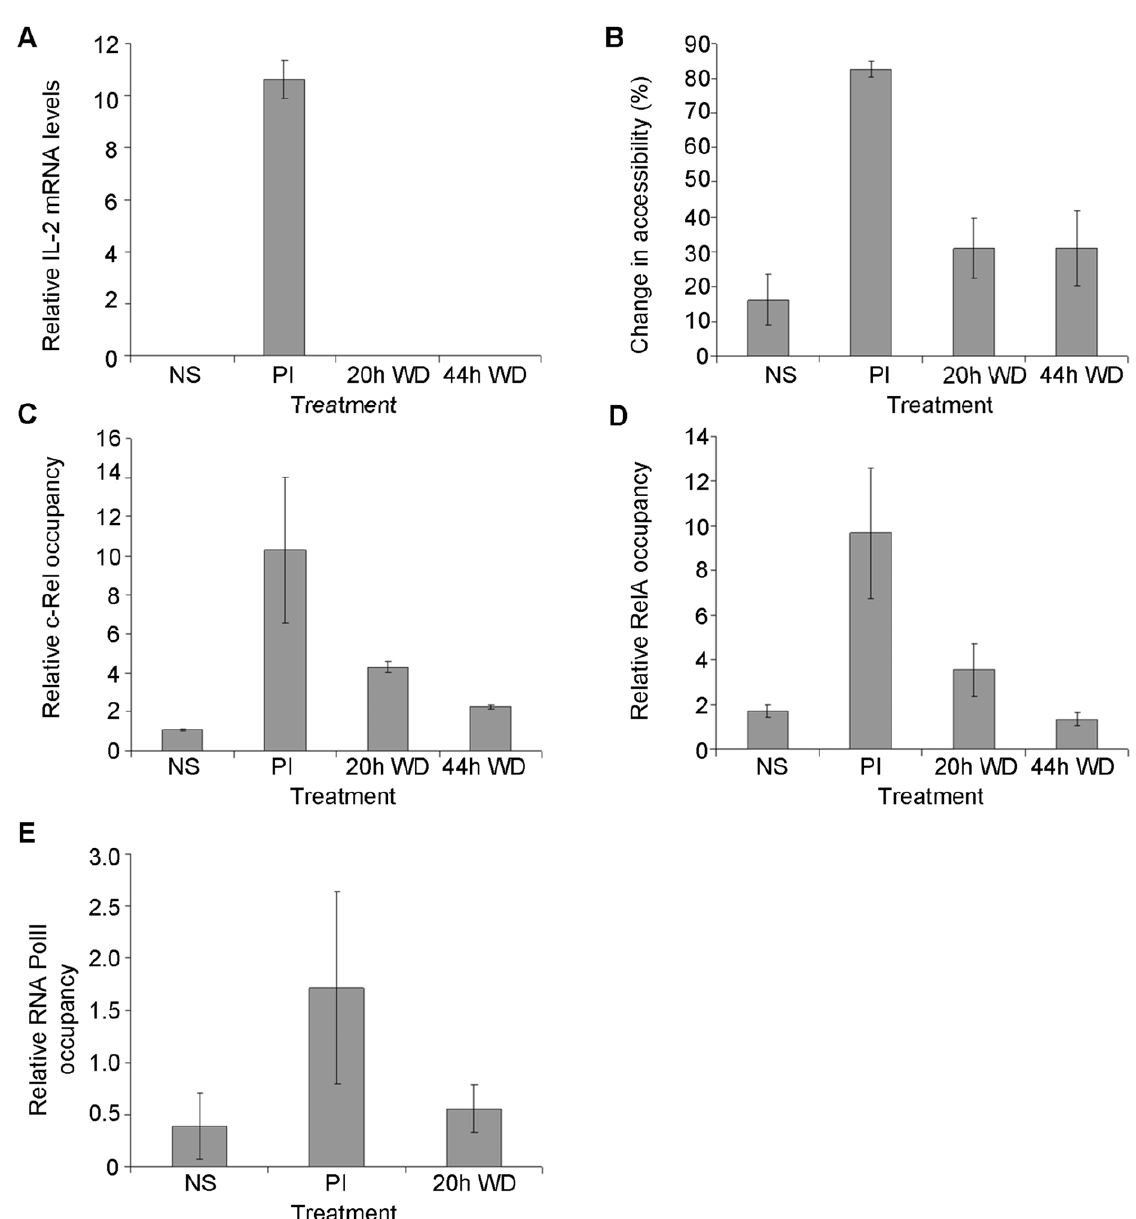
Figure 4. NF- k B and RNA Polymerase II are associated with the active IL-2 promoter. (A) IL-2 mRNA levels relative to GAPDH were determined in EL-4 T cells either left untreated or treated with PI for 4 h (PI), then the stimulus withdrawn (WD) for the indicated times. (B) IL-2 promoter accessibility was determined by CHART-PCR in cells treated as in (A). (C–E) c-Rel (C), RelA (D) and RNA polymerase II (E) occupancy was determined at the IL-2 promoter by ChIP in cells treated as indicated. Occupancy levels are shown relative to the inactive rhodopsin promoter. The mean and standard error of three independent experiments (A–D) or mean and standard deviation of two experiments (E) is shown.